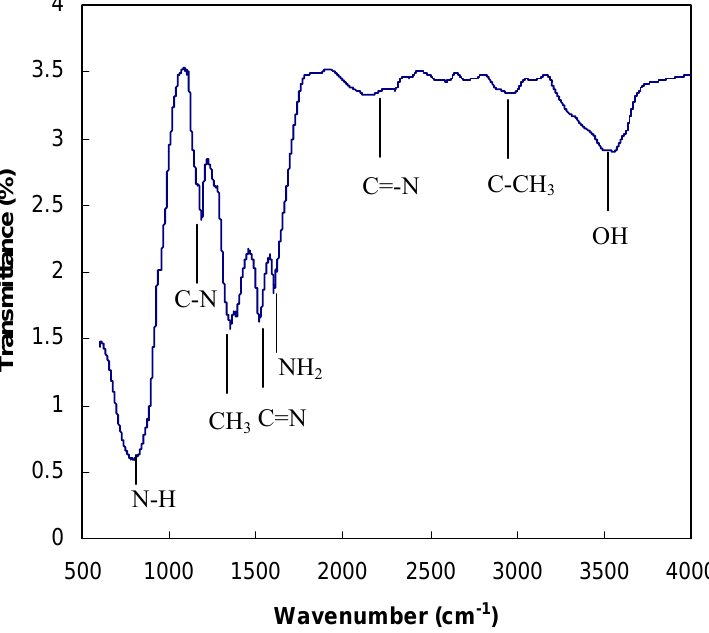
Figure 4. Typical FT-IR spectrum of the CNT electrode after electrochemical polyaniline-enzyme